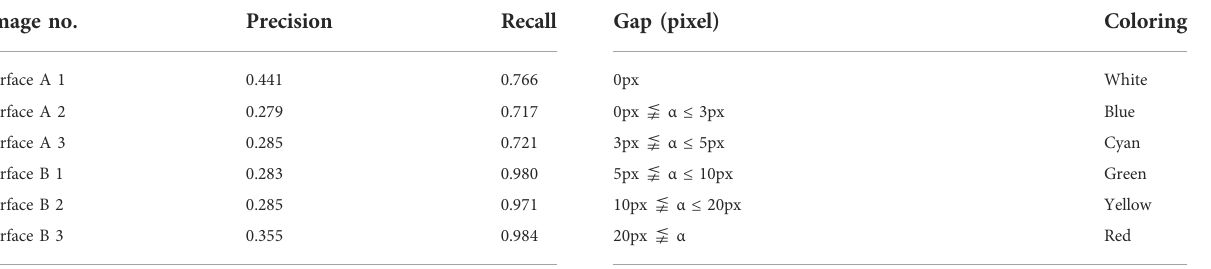
TABLE 4 The range of α and